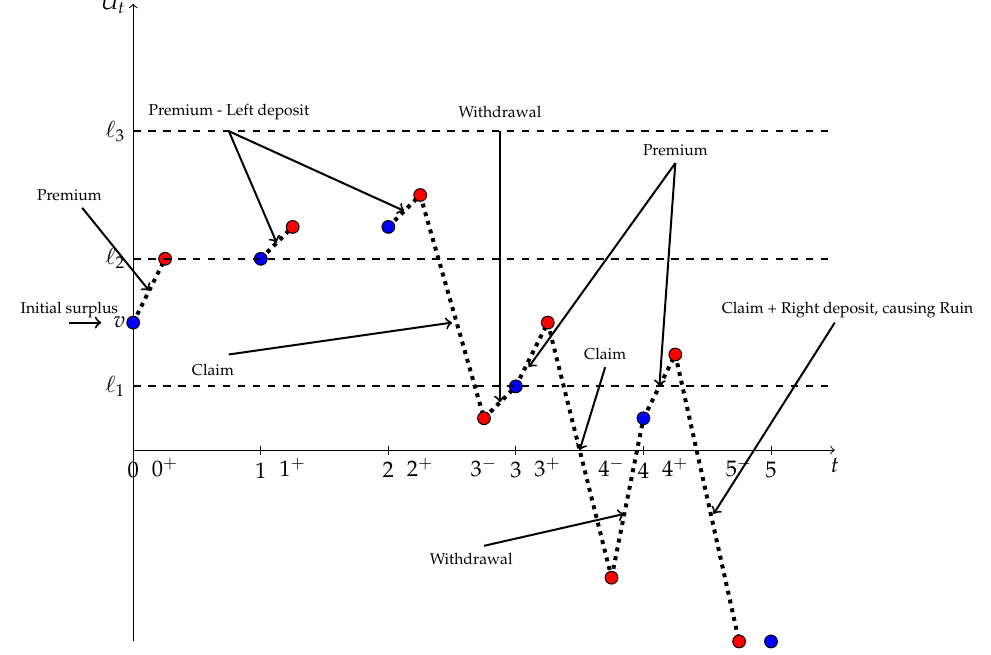
Figure 1. Sample evolution of the surplus process { U t , t ∈ N }